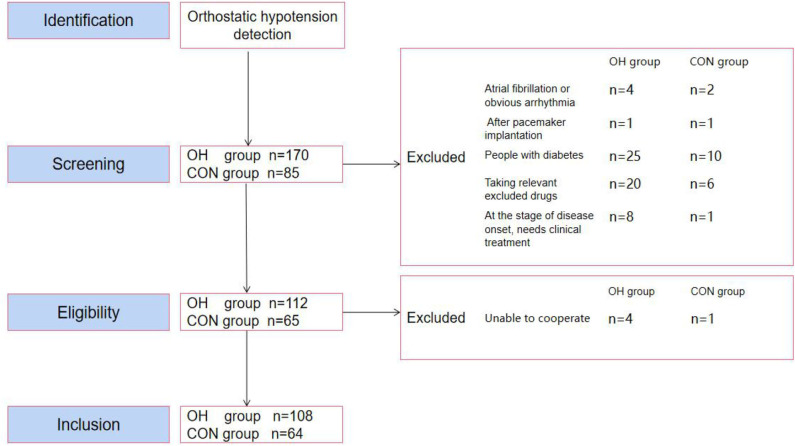
Participant selection flow diagram. OH, orthostatic hypotension group; CON, control group.